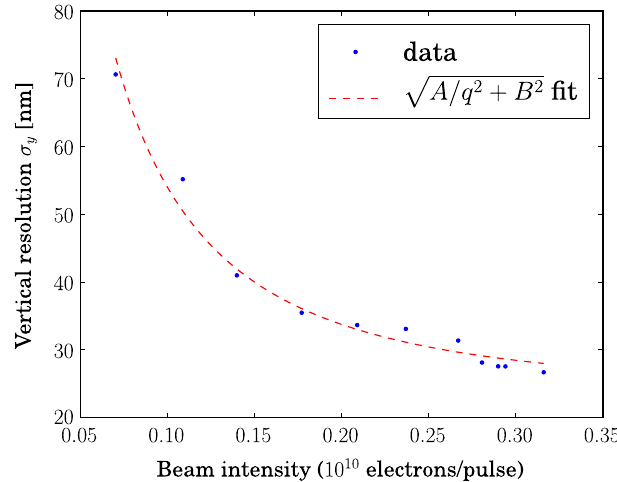
FIG. 21. Resolution of MQM15FF in the y direction as a function of bunch charge. The dashed line is a fit to the function ffiffiffiffiffiffiffiffiffiffiffiffiffiffiffiffiffiffiffiffiffiffiffi p A=q 2 þ B 2